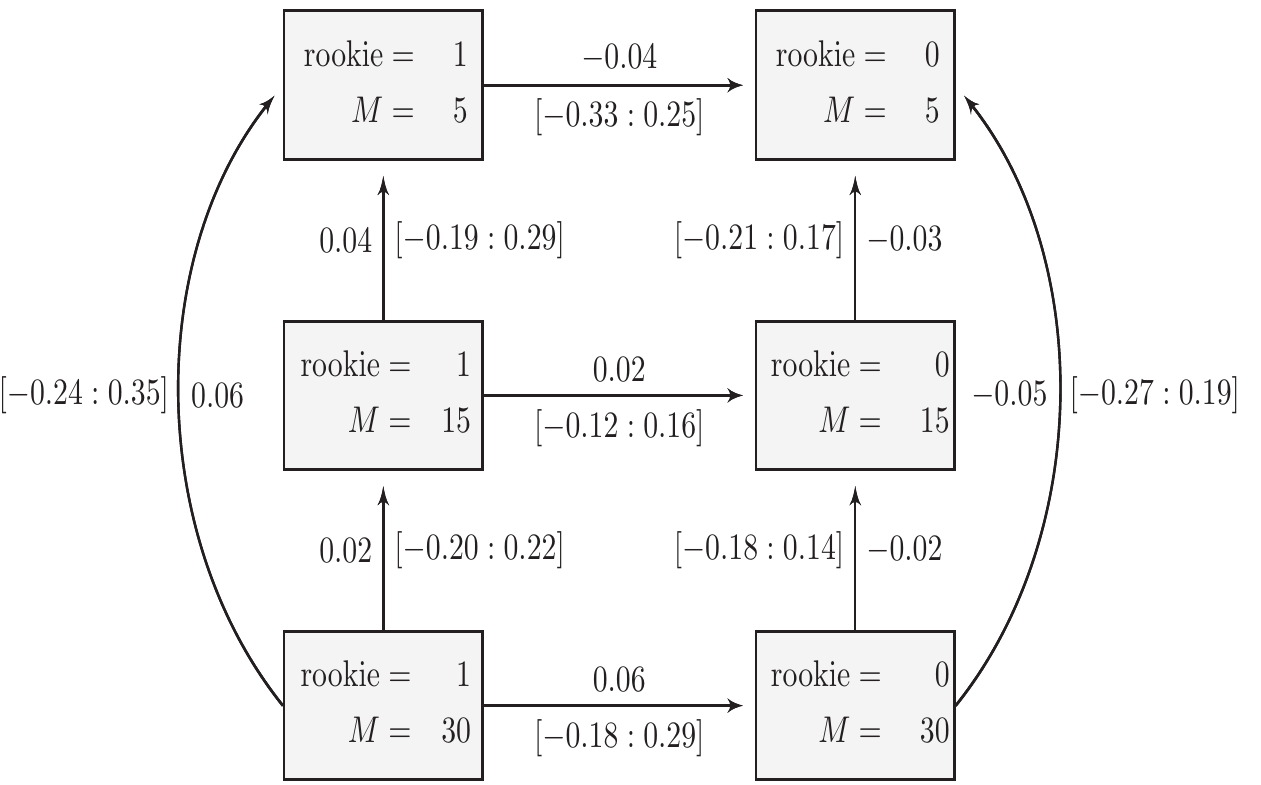
Figure 5. Second-order interaction first differences for open lists ( open = 1